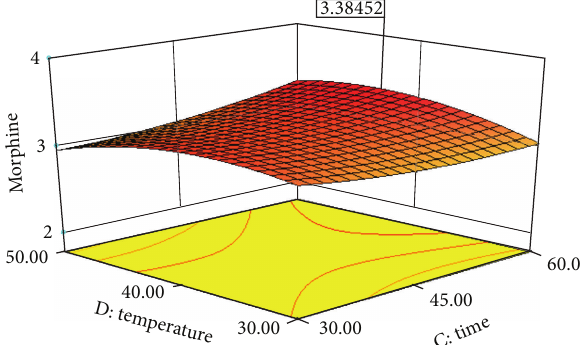
Figure 3: Response surface plot for the EY of poppy straw as a function of solvent pH ( 𝑋2 ) to extraction time ( 𝑋3 ).